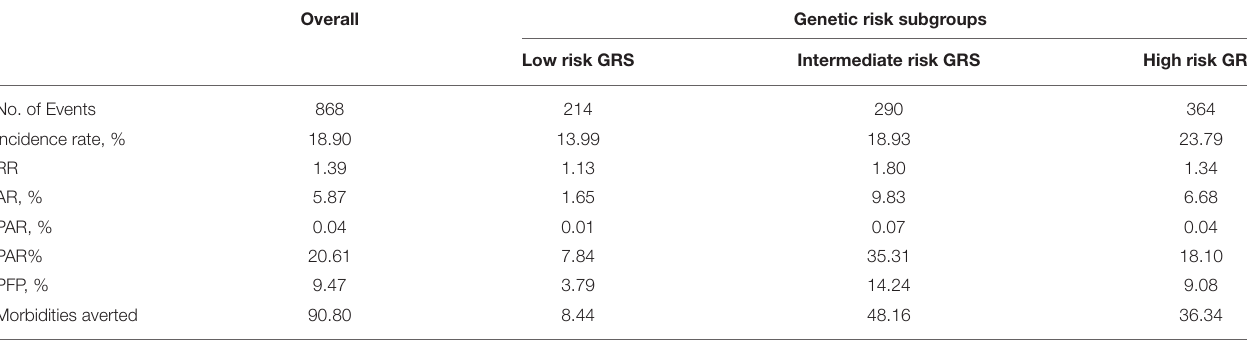
TABLE 3 | Epidemiological indicators of lifestyle on developing hypertension in different genetic risk subgroups. Overall Genetic risk subgroups Low risk GRS Intermediate risk GRS High risk